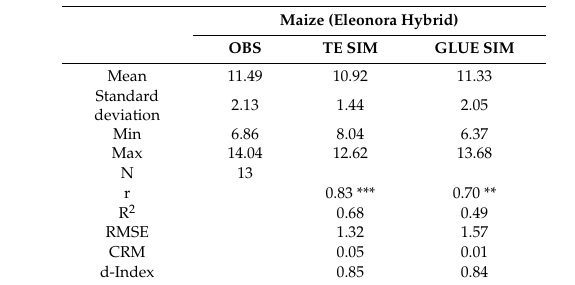
Table 10. Statistical results of observed (OBS) and simulated (SIM) values of grain yield (t ha − 1 ) of maize (Eleonora hybrid) for the calibration of CSM-CERES-Maize